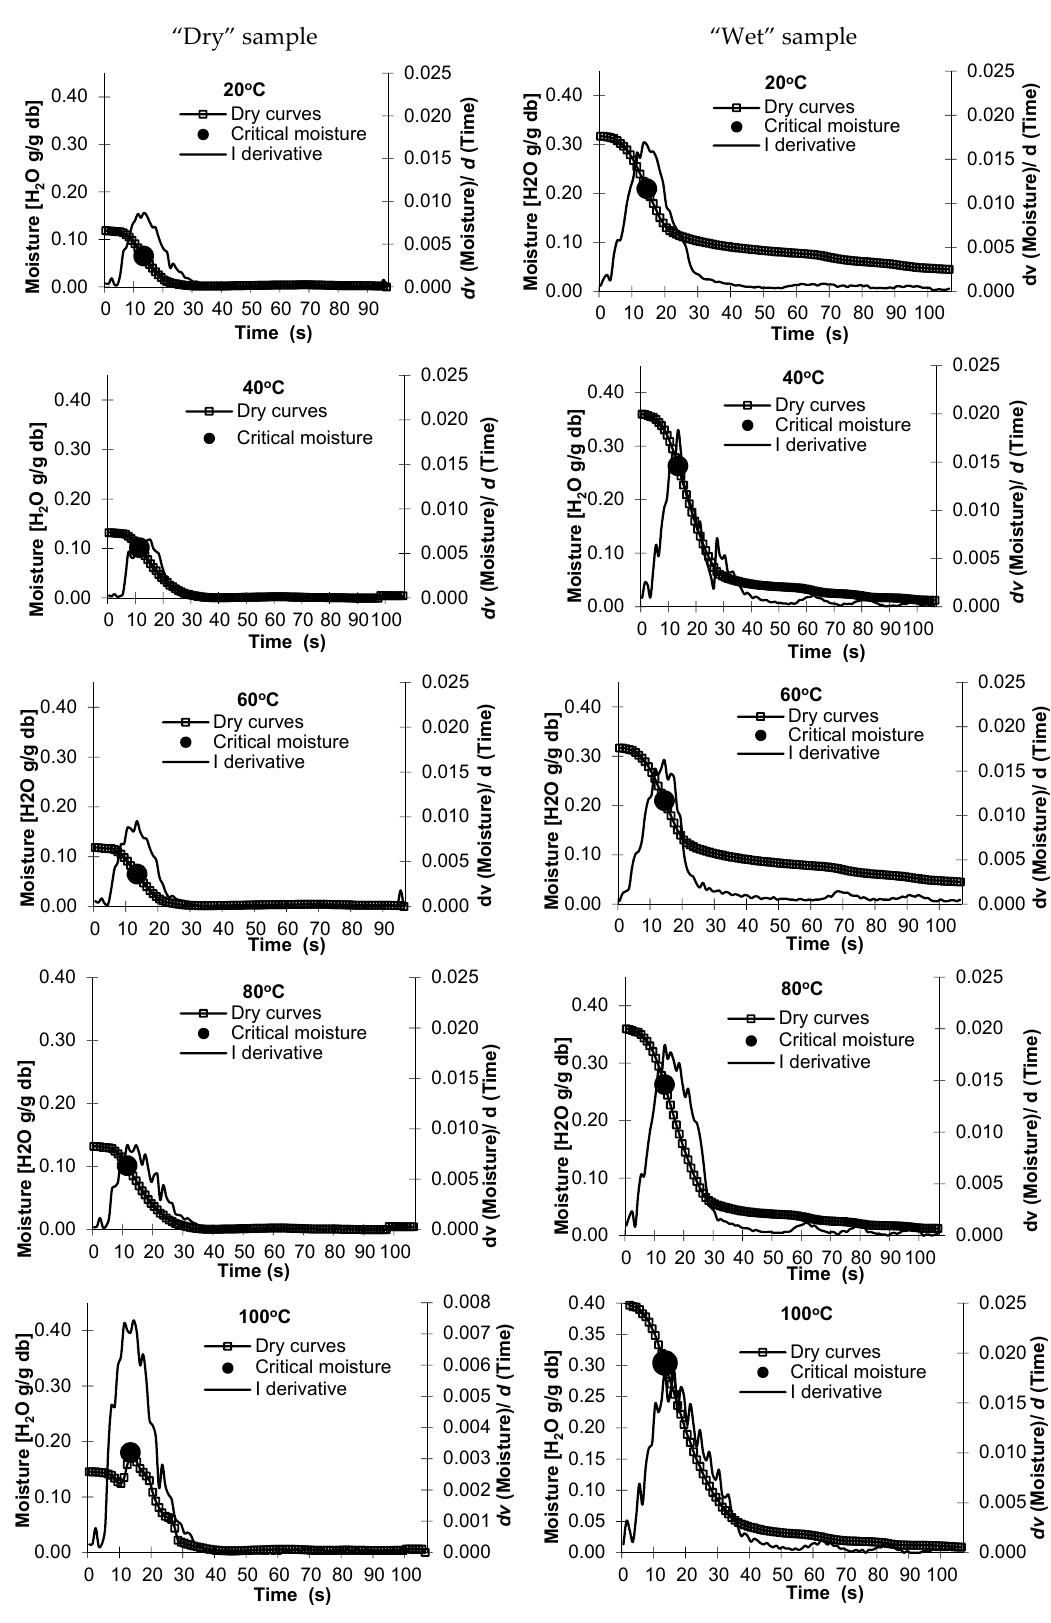
Figure 1. The course drying curves of the “dry” and “wet” potato starch, at a temperature of 20 °C, 40 °C, 60 °C, 80 °C, and 100 °C.